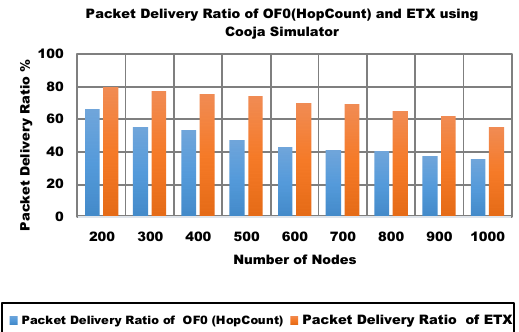
Figure 16. packet delivery in Cooja simulator using OF0 and ETX with random network topology.